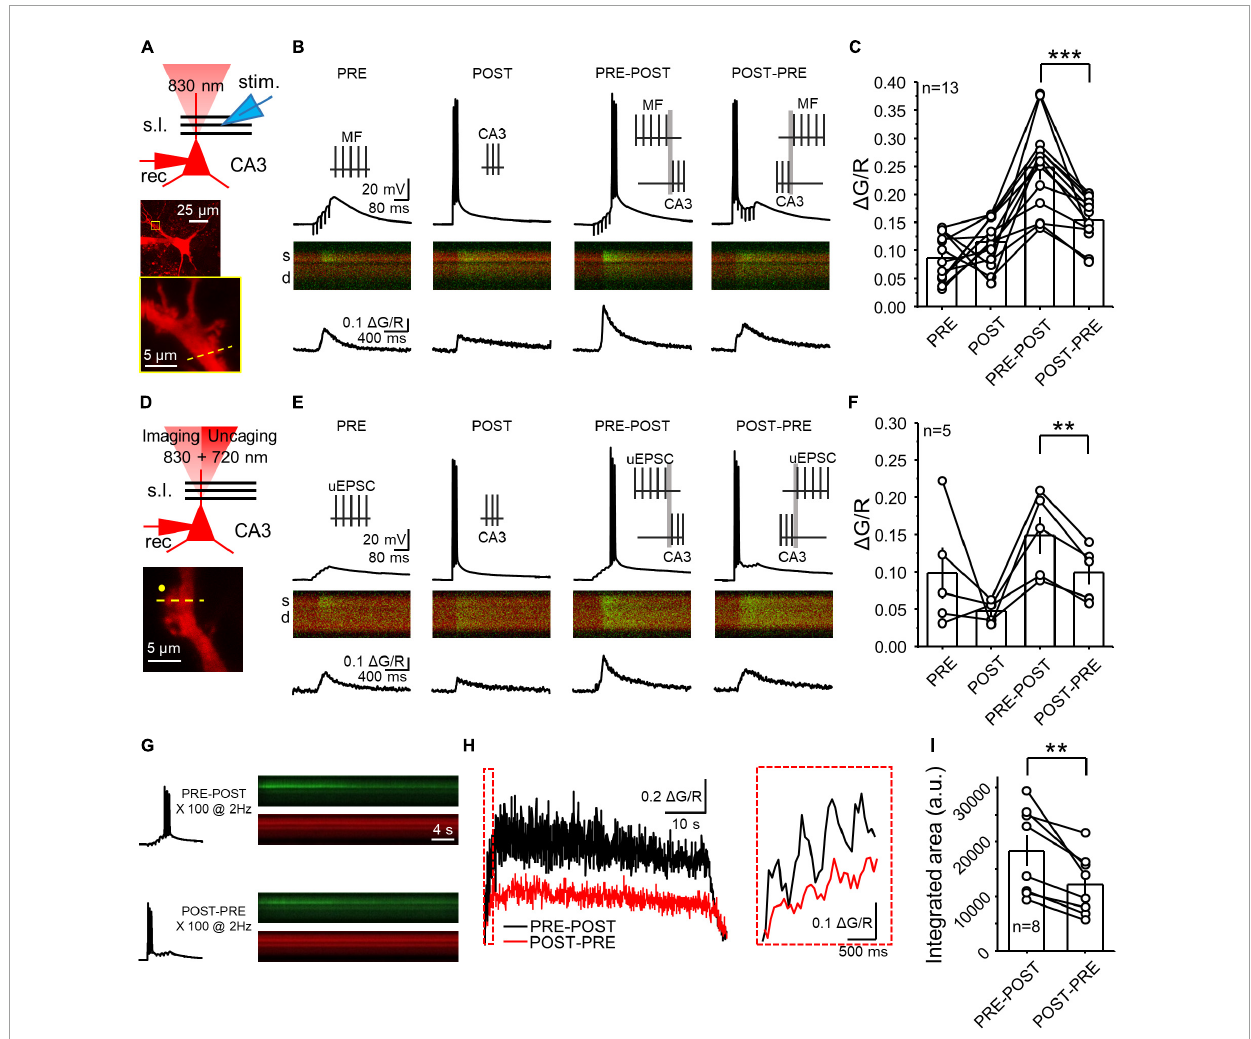
FIGURE1 NMDAR LTP was associated with a larger postsynaptic calcium rise than NMDAR LTD at the MF-CA3 synapse. (A) Experimental recording configuration (top). Simultaneous excitation of Alexa 594 and Fluo-5f loaded via a patch pipette was performed with a 2P laser tuned at 830 nm. Representative CA3 pyramidal cell loaded with Alexa 594 (middle) and inset showing magnification of the imaged postsynaptic TE (yellow box). High magnification image showing the scanning line (yellow dashed line) on the TE (bottom). s.l.: stratum lucidum; θ stim: theta glass stimulus pipette; rec: recording pipette. (B) Electrophysiological recordings and calcium responses obtained from a CA3 pyramidal neuron. Stimulation patterns employed (top): PRE (MF electrical stimulation – 5 pulses at 50 Hz); POST (CA3 pyramidal cell action potentials – 3 spikes at 100 Hz); PRE-POST (delay 10 ms between bursts); and POST-PRE (delay 10 ms between bursts). Fluorescence profile (middle) of the green signal (Fluo5f) superimposed with the red signal (morphological dye Alexa 594). S: spine; d: dendrite. Fluorescence quantification reported as (cid:49) G/R over time (bottom). (C) Summary of mean peak (cid:49) G/R across all patterns of stimulation. Here and in all figures, circles linked by a line represent individual experiments performed in the same cell. (D) Experimental configuration used to perform electrophysiology, calcium imaging and glutamate uncaging (top). Excitation wavelengths employed were 830 nm (for imaging) and 720 nm (for glutamate uncaging). High magnification image showing the position of the uncaging laser beam (yellow circle) the scanning line (yellow dashed line) on the TE (bottom). (E,F) Same as panels (B,C) but employing glutamate uncaging instead of MF stimulation. (G) Single electrophysiological response (left) and fluorescence profile during full induction protocol for NMDAR LTP and LTD (right). (H) Calcium responses of the experiment showed in panel (G) expressed as (cid:49) G/R over time. Boxed area shows a magnification of (cid:49) G/R during the first 4 pairings. (I) Summary of (cid:49) G/R change during the full induction protocols expressed as integrated area under the curve. Data are presented as mean ± SEM. ** p < 0.01, *** p <